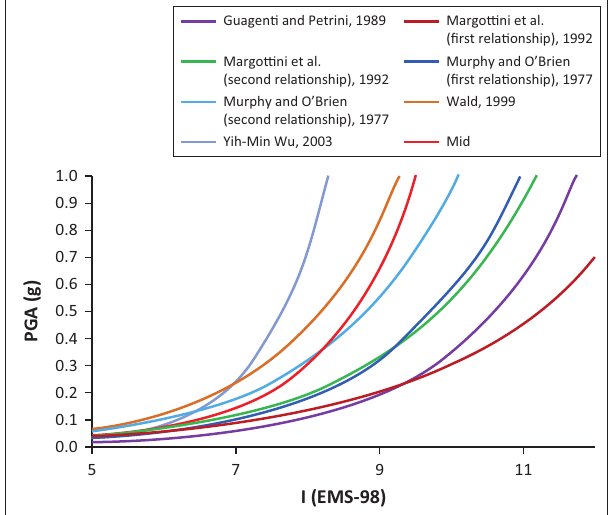
FIGURE 5: Different correlation between peak ground acceleration and intensity.